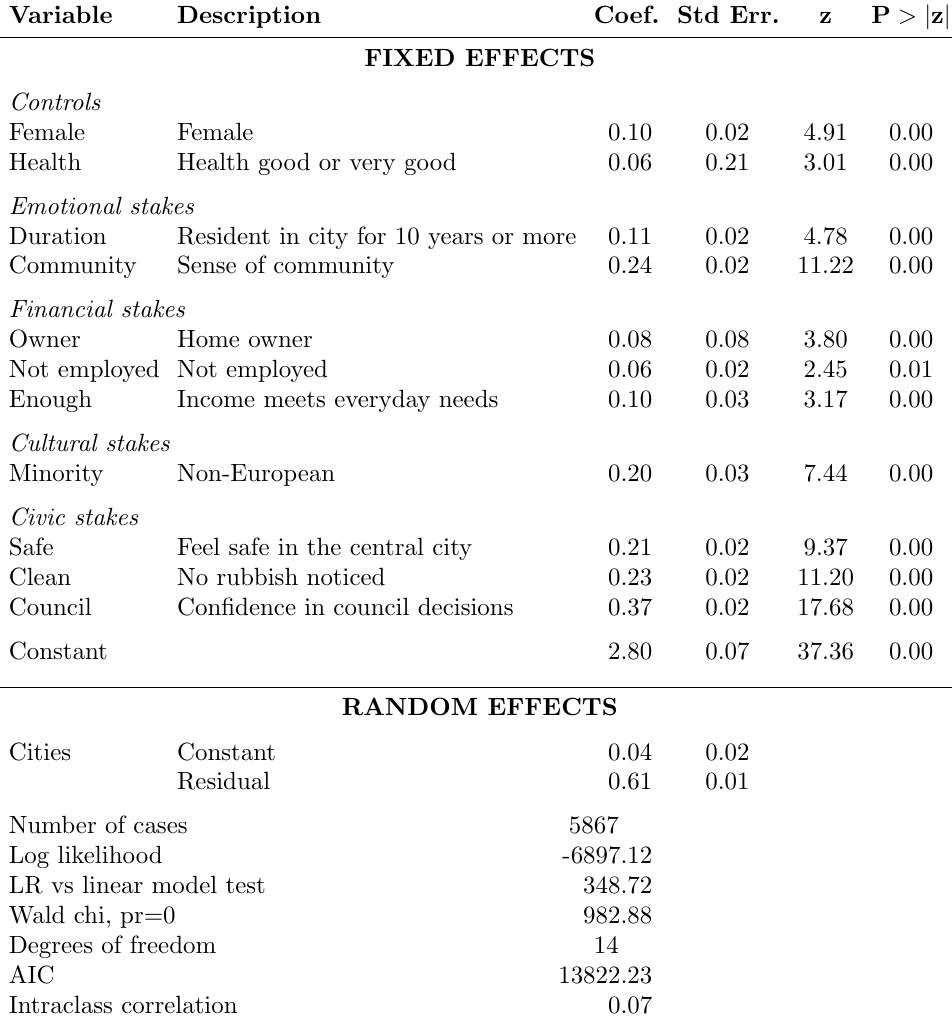
Table 5: The distribution of urban pride. Stake holding fixed effects and city random effects. New Zealand,